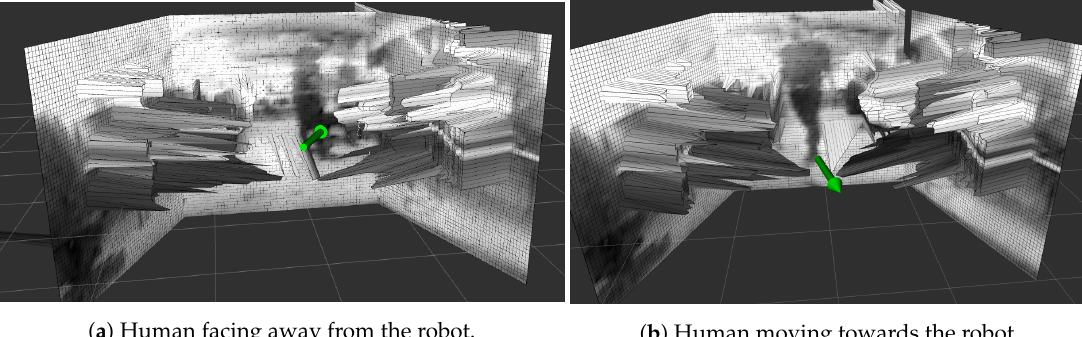
Figure 17. Human movement experiment. The green arrow shows position of the human erased from the map and points to the predicted direction of movement.